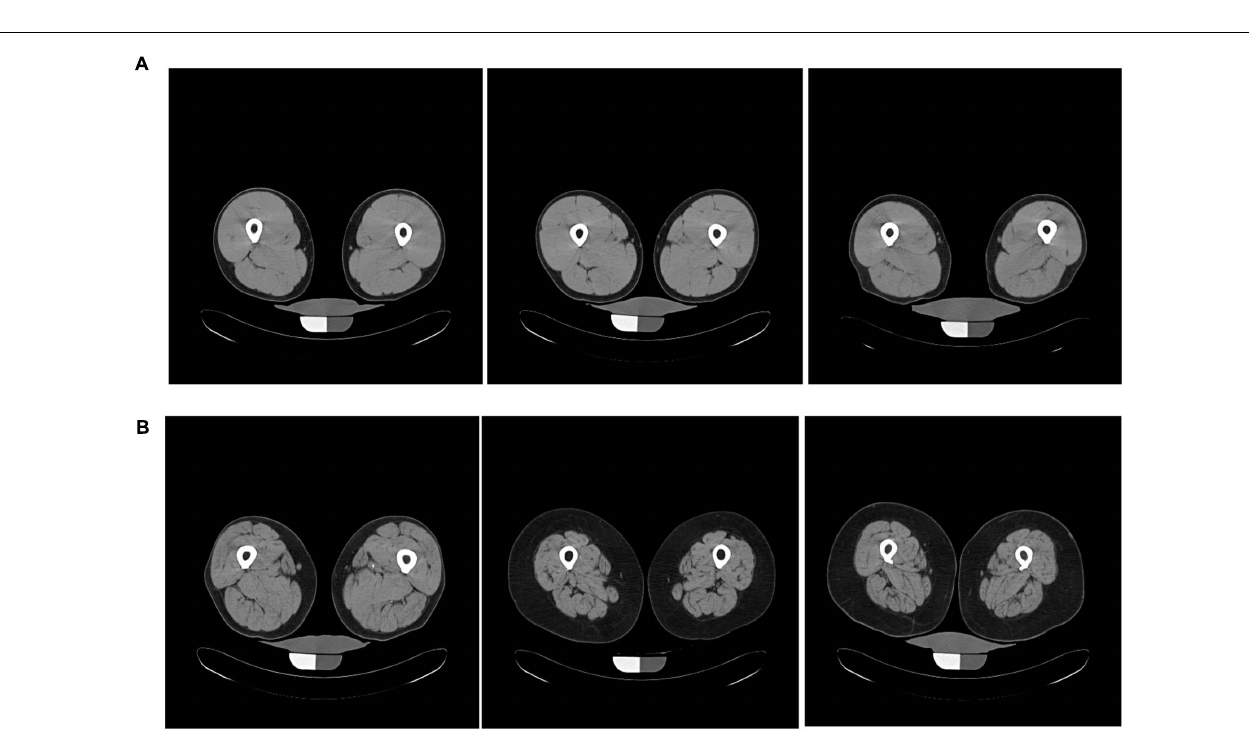
FIGURE 2 | Axial mid-thigh computerized tomography images acquired from three participants with (A) low EMCL measurements (0.0031 ± 0.0002) and three participants with (B) high EMCL measurements (0.202 ± 0.085). Participants with low EMCL exhibit higher muscle CT density when compared to those with high EMCL